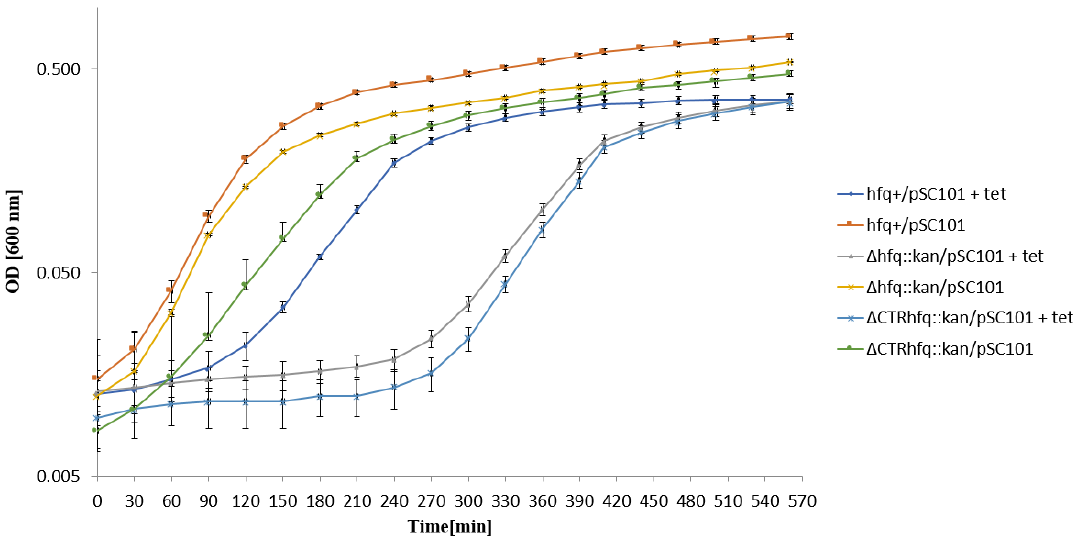
Figure 5. Growth of E. coli strains hfq + , Δ hfq :: kan , and Δ CTR hfq :: kan bearing plasmid pSC101 in the LB liquid medium containing 68 μ g/mL tetracycline (+tet) or devoid of this antibiotic (no mark) at 37 °C, after transferring bacteria from antibiotic-free LB and diluting the culture 10-times in a fresh LB medium (with or without tetracycline) at time 0. The presented data indicate mean values from three independent experiments with error bars showing SD. Minimal inhibitory concentrations (MIC) of tetracycline for hfq + , Δ hfq :: kan , and Δ CTR hfq :: kan hosts bearing pSC101 under these conditions were >2048, 1024, and >2048 μ g/mL, respectively.